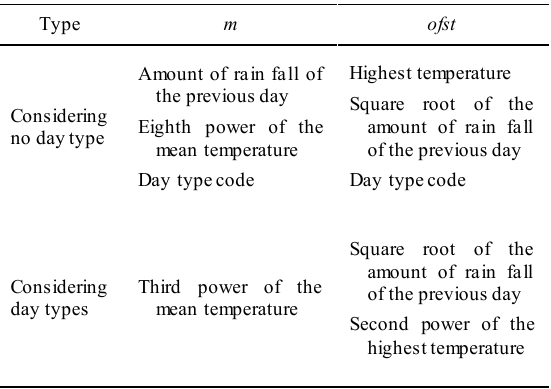
Table 1. Explanatory